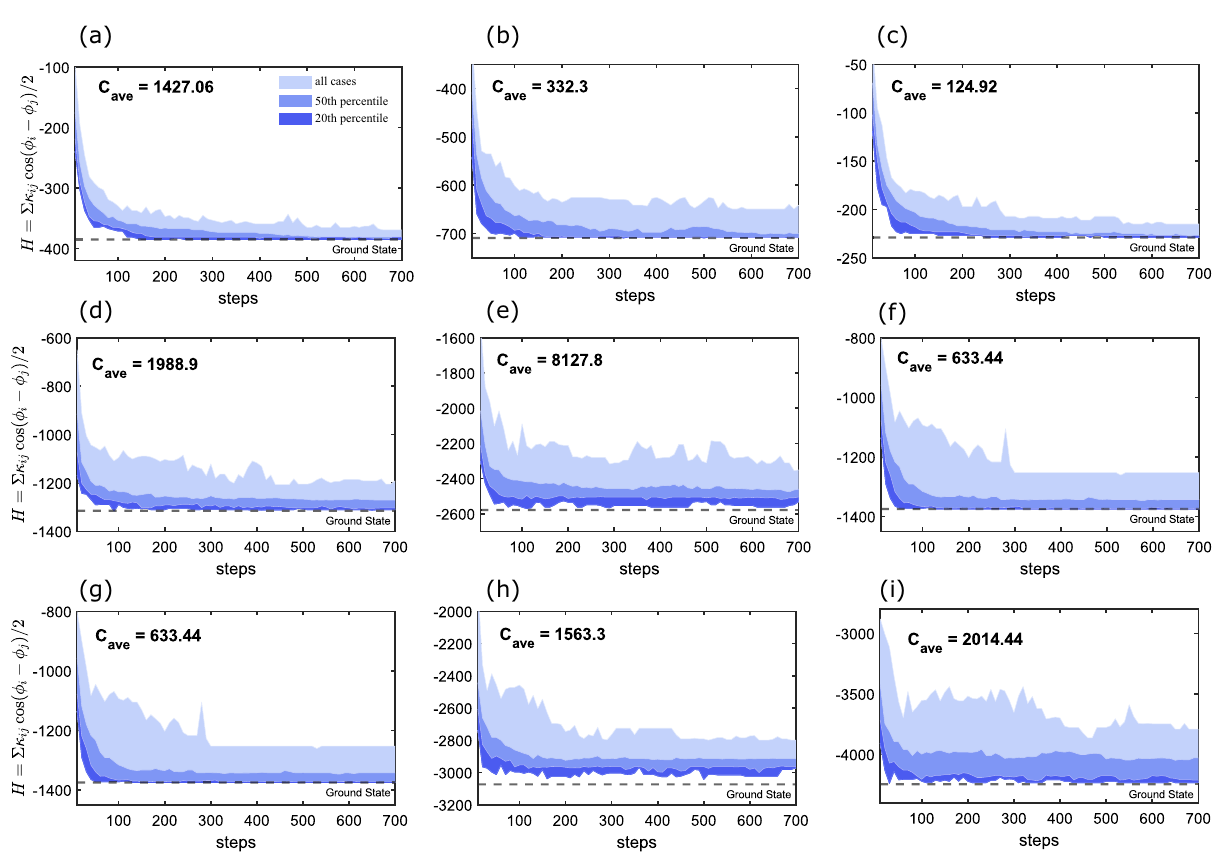
Fig. 4 Adiabatic gain method applied to the Ising problem. Solution to the Ising ( q = 2) problem on 100-node graphs from all 9 classes in the Biq-Mac Library with known ground states. The average cut size C ave corresponding to the fi nal average energy H ave is also shown on each panel. a – i The distribution (cid:2) ϕ Þ = 2 (where κ of the equilibrium state energies H ¼ ∑ κ ij cos ð ϕ ij is the coupling strength of the i th and j th oscillators and i j state phase) versus the number of iterations for 1000 random initial conditions. The horizontal axis shows the total number of steps (from 10 to 700). In all cases, the gain is linearly increased from g = 0 to g = 2.5, while the time-step size is Δ =